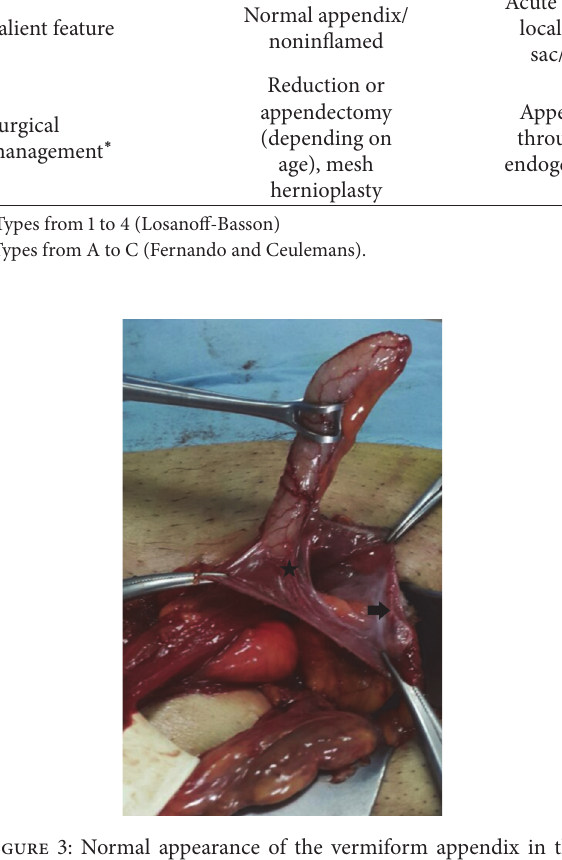
Figure 3: Normal appearance of the vermiform appendix in the inguinal hernia sac. Severe adhesions (star) between the vermiform appendix and surrounding hernia sac (arrow).